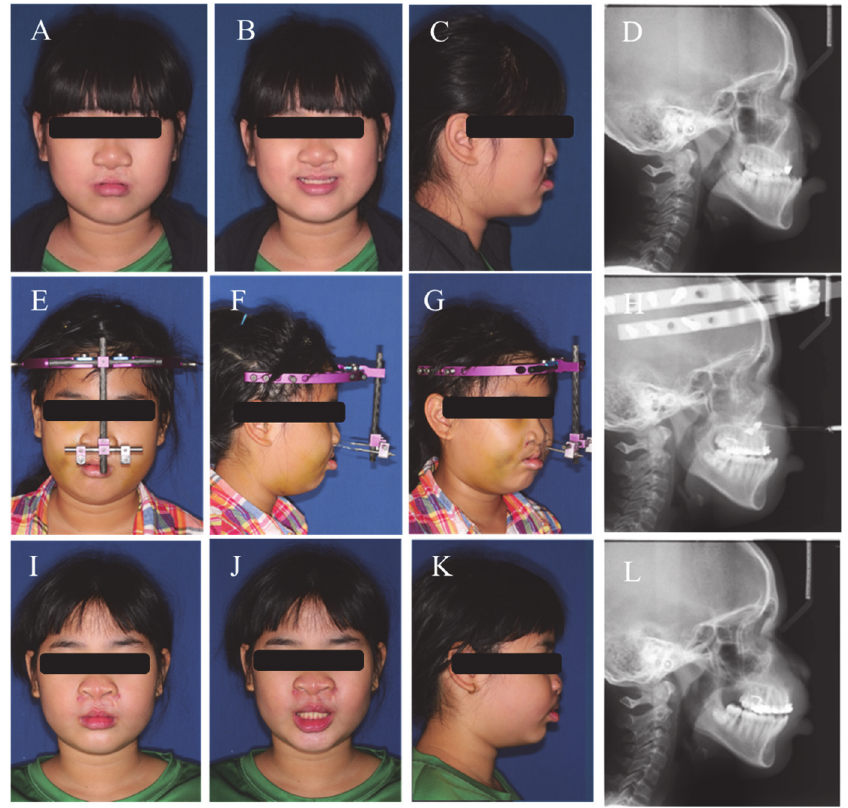
Figure 1. An 11-year-old girl with Left Cleft Lip and Cleft Palate (CLCP) underwent primary lip/palate repair and transcutaneous maxillary distraction osteogenesis (TMDO) to enhance her facial profile and dental alignment (Case-3). The following images provide a visual timeline of her progress: ( A – D ) Initial, ( E – H ) During TMDO treatment, and ( I – L ) two days immediately after TMDO